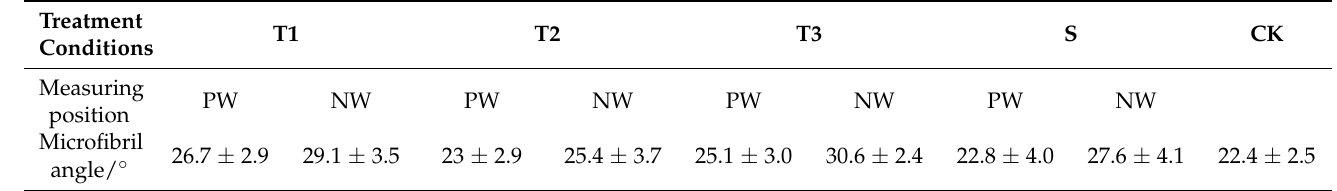
Figure 7. XPS wide scanning spectrum ( a ) and the scanning spectrum (101–102 eV) of silicon ( b ) in poplar. T1, T2, T3 for newly formed wood after the 1,10,100 mmol/L TEOS treatment, C for the newly formed wood of the untreated tree, S for the newly formed wood of the SiO 2 colloidal injected tree. Table 2. Microfibril angle in different positions of poplar under different treatment conditions. The values after the +/ − sign represent the standard deviation; PW represents the previously grown wood; IP represents the injection point; NW represents the newly grown wood; T1, T2, T3 represent the 110,100 mmol/L TEOS modification treatment group; S represents the SiO 2 colloidal injection group; CK represents the unmodified treatment